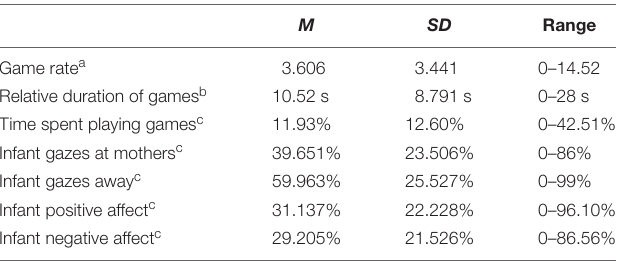
TABLE 3 | Descriptive statistics for behavioral measures of the present